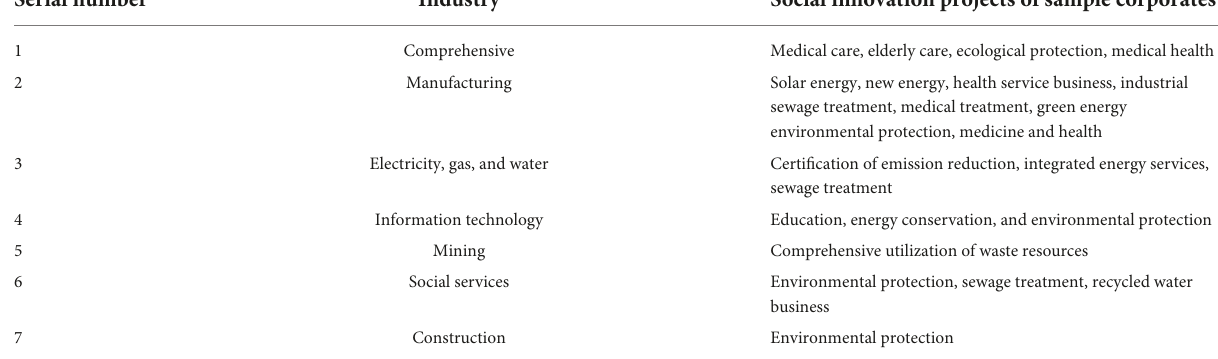
TABLE 2 Classification of industry and social goal-oriented projects in the